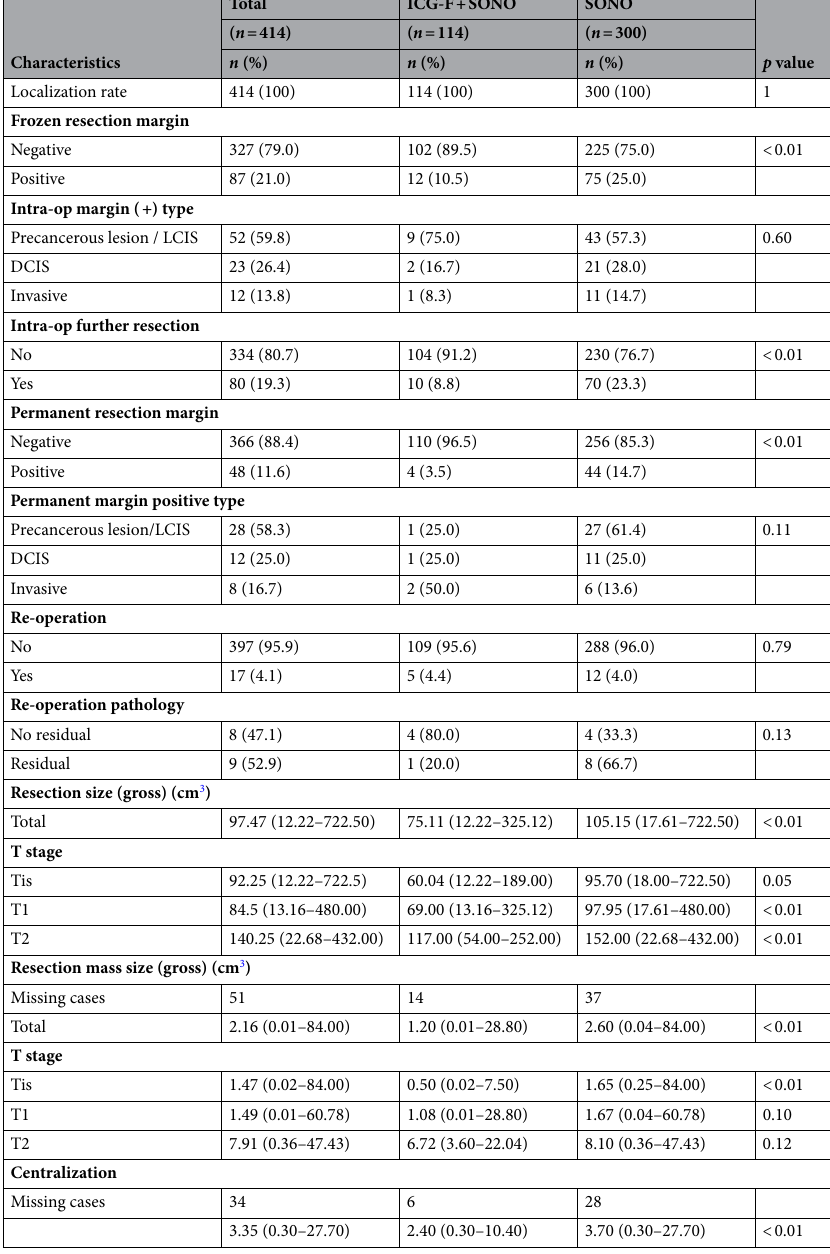
Table 2. Surgery results for both groups. ICG-F indocyanine green fluorescence, SONO sonography, LCIS lobular carcinoma in situ, DCIS ductal carcinoma in